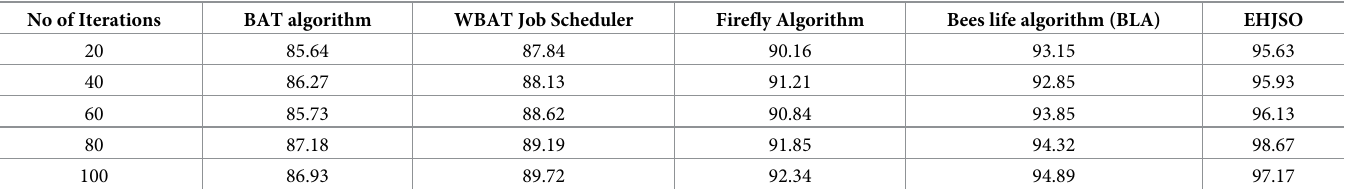
Table 6. Success rate analysis for EHJSO method with existing